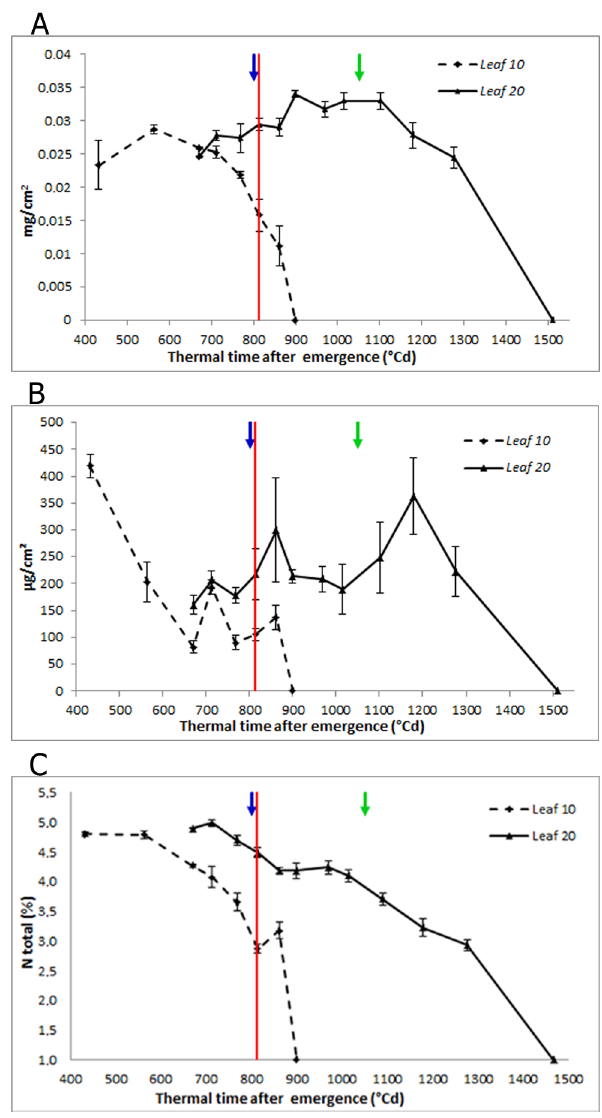
Figure 2. Physiological measurements of the progression of senescence. (A) Chlorophyll content in mg.cm 2 2 . (B) Total soluble carbohydrates in m g/cm 2 and (C) Total nitrogen percentage. The red line indicates anthesis time. Blue and green arrows show the date when the Ha-NAC01 expression ratio reaches a value of 4 (Log2 ratio=2) relative to first sampling point in leaf 10 and 20, respectively, determined by qPCR ( Ha-EF1 a as RG). Error bars correspond to standard